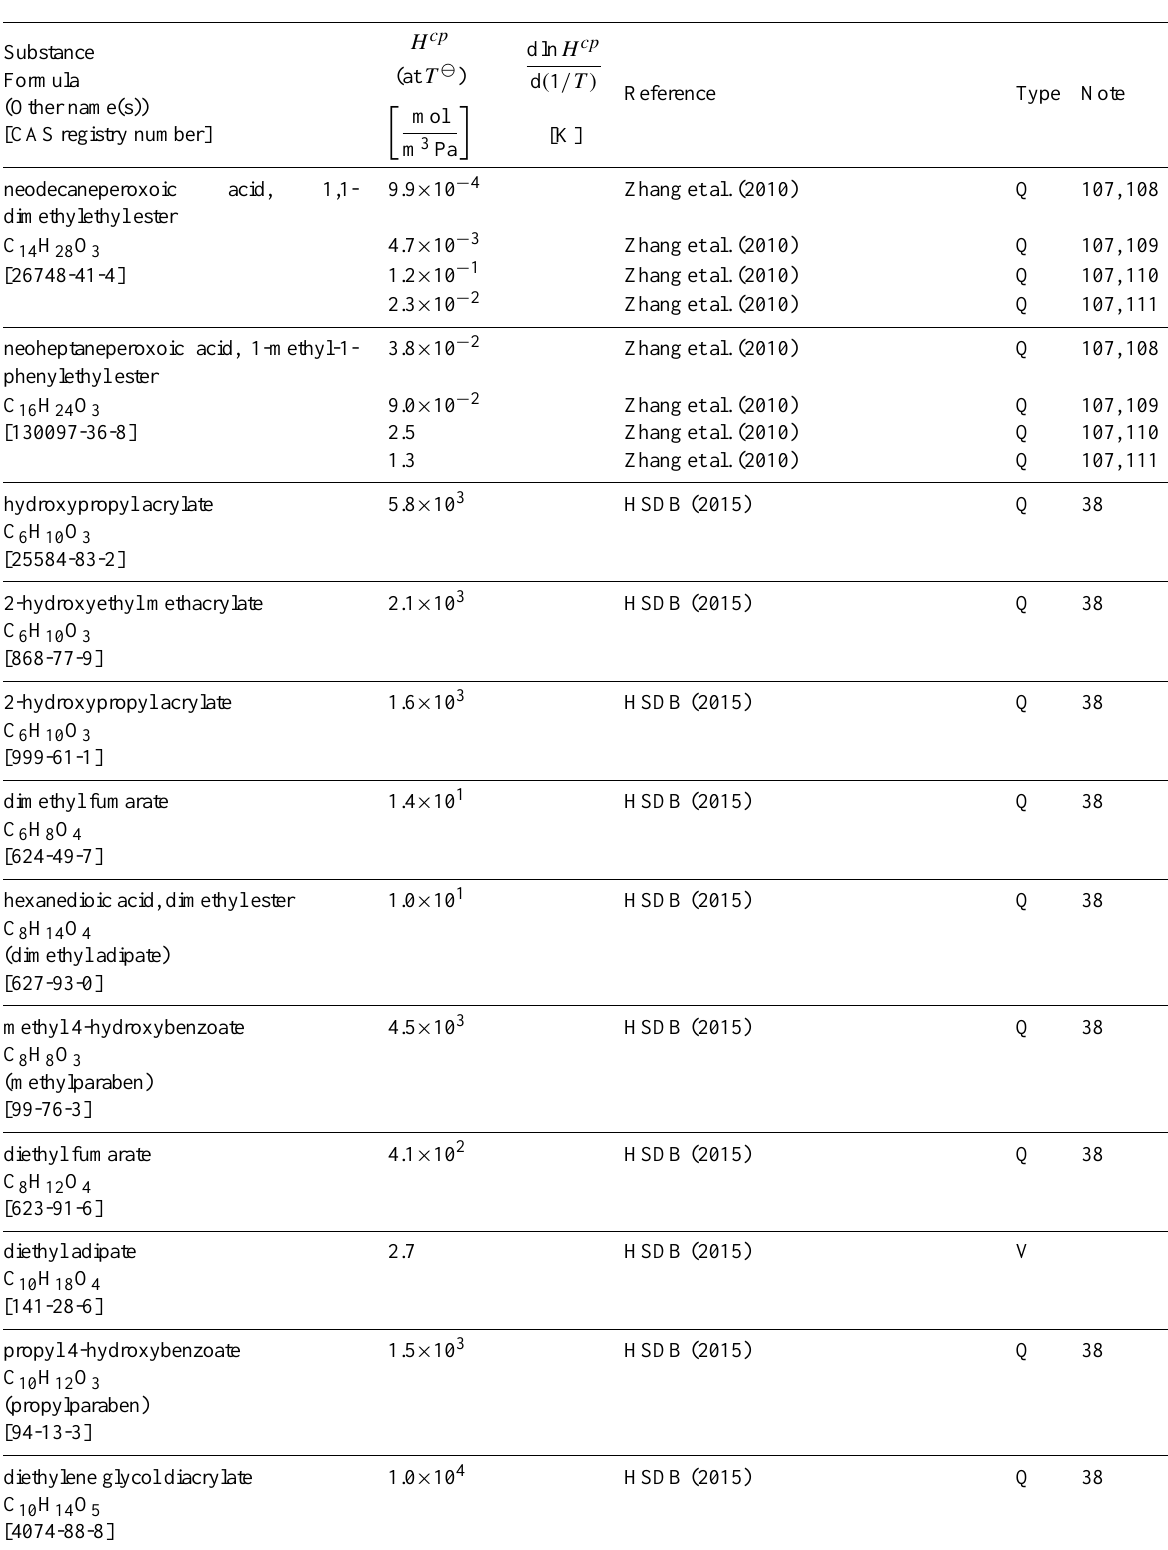
Table 6: Henry’s law constants for water as solvent